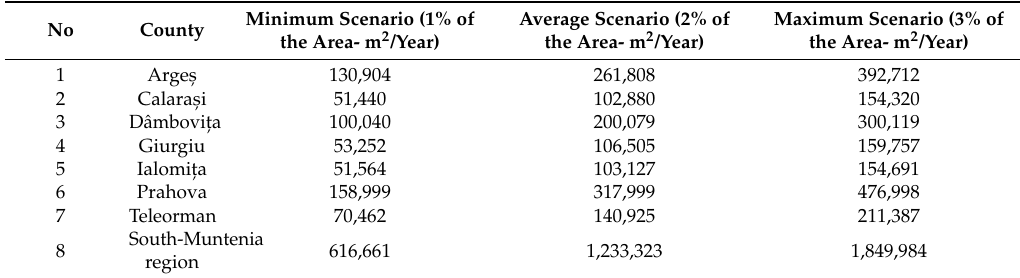
Table 4. The surface of the dwellings rehabilitated annually in each scenario for each county of the South Muntenia region 1